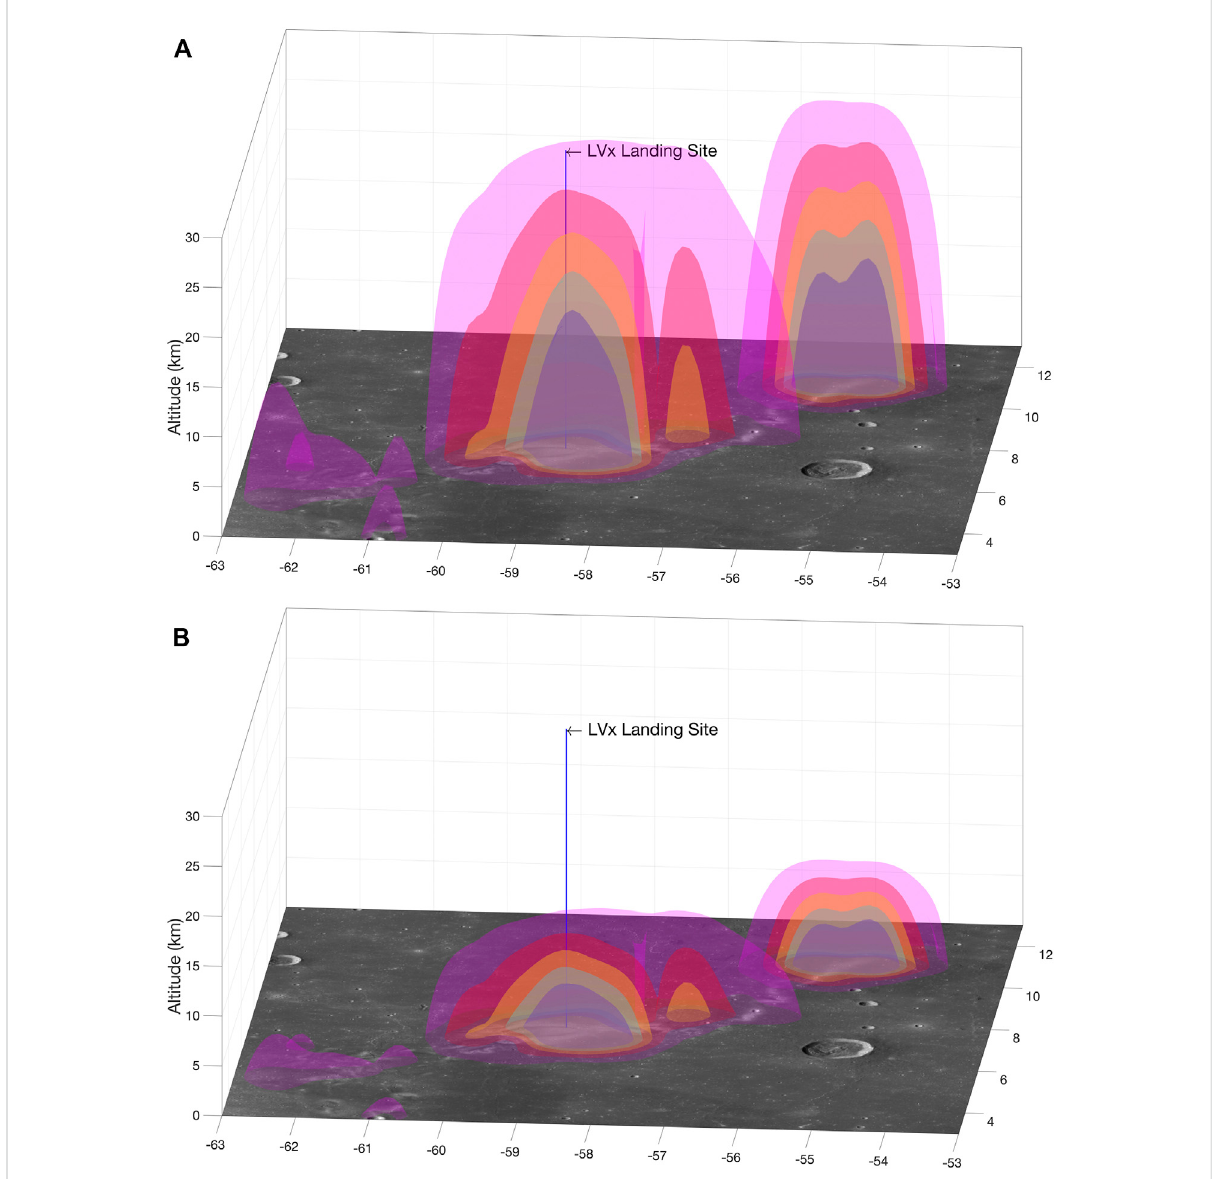
FIGURE 9 The top plot (A) visualizes minimally compressed mini-magnetospheres (I = t wake ). The bottom plot (B) visualizes maximally compressed mini- magnetospheres (t = t noon ). The mini-magnetosphere boundaries were de fi ned at 5 layers of intensity as 15 nT (purple), 35 nT (pink), 55 nT (orange), 75 nT(green),and95 nT(lightblue)thenprojectedontoabasemapof415 nmwavelengthdatafromLROCWAC.LunarVertexlandingsiteindicated by the vertical dark blue arrow at 7.585 ° N, 58.725 °